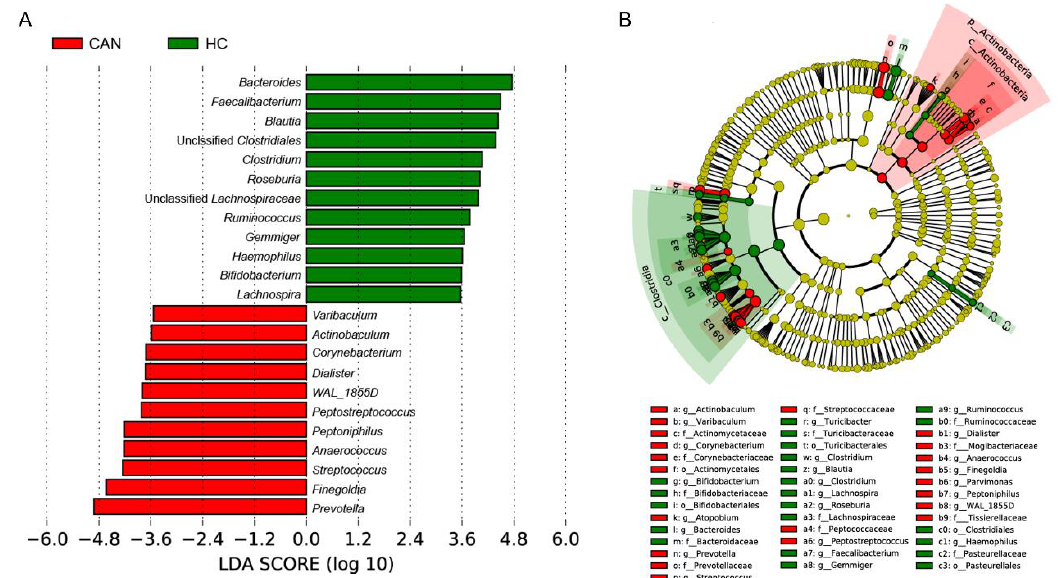
Figure 4. Linear discriminant analysis (LDA) effect size (LEfSe) analysis for fecal microbiota abundance based on clinical features (HC vs. CAN). ( A ) Shows the representative genera for HC and CAN. ( B ) Cladogram of taxa associated with HC and CAN.